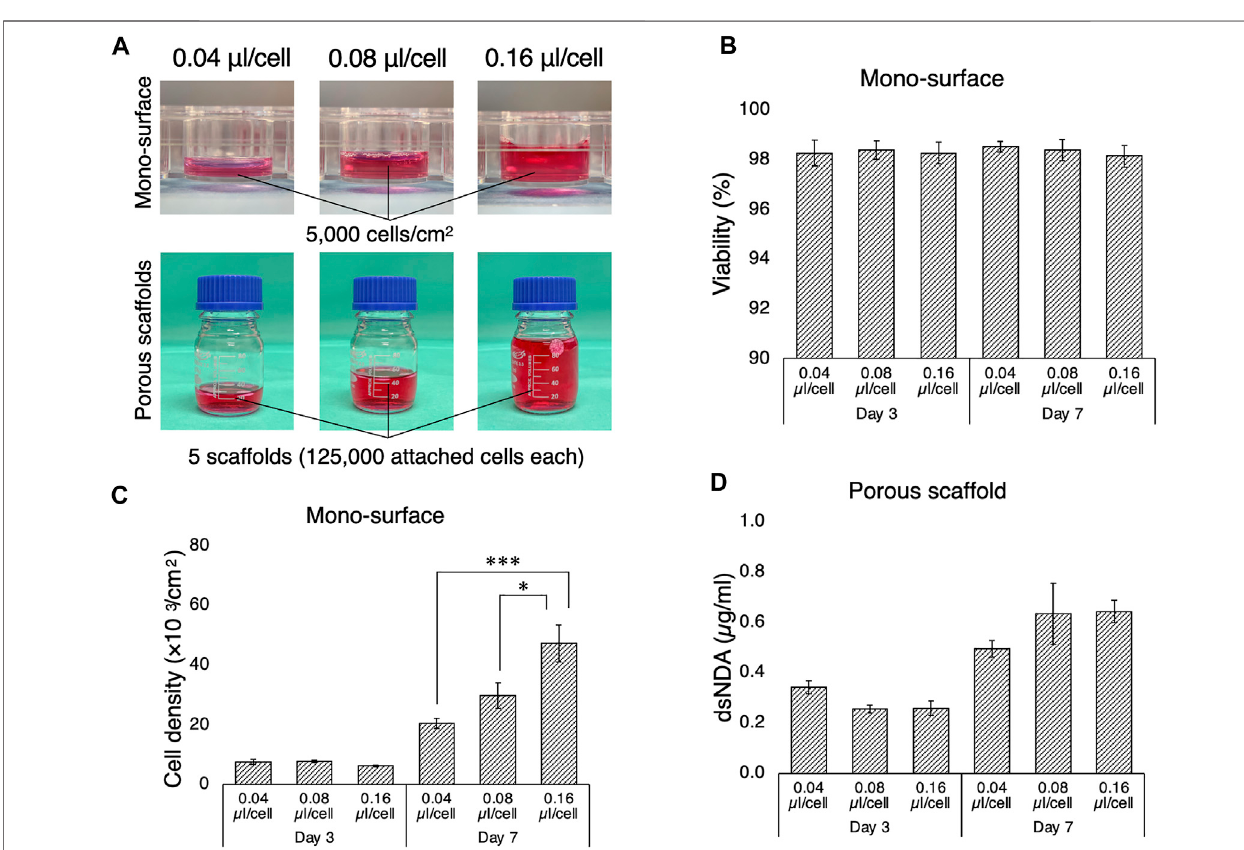
FIGURE3| Growth ofrBMSCinculturemedium atdifferentmedium-to-cellratios. (A) Medium-to-cellratiosof0.04,0.08,and0.16 µm/cellatthepointofseeding weretested on2Dmono-surfaceand3Dporousscaffolds. (B) Cellsseededonthemono-surfacemaintainedhighviabilityregardlessofmedium-to-cellratio. (C) Onthe mono-surface, cell growth was enhanced at a medium-to-cell ratio of 0.04 µl/cell compared to 0.08 and 0.16 µl/cell on day 3, but the tendency was reversed on day 7 whenthecelldensityapproachedcon fl uence. (D) On3Dporousscaffolds,quanti fi cationofdouble-strandDNA(dsDNA)indicatedthatthemediumratioof0.04 µl/ cell yielded the highest dsDNA on day 3, but medium ratios of 0.08 and 0.16 µl/cell yielded higher dsDNA on day 7. * p < 0.05, *** p < 0.001.